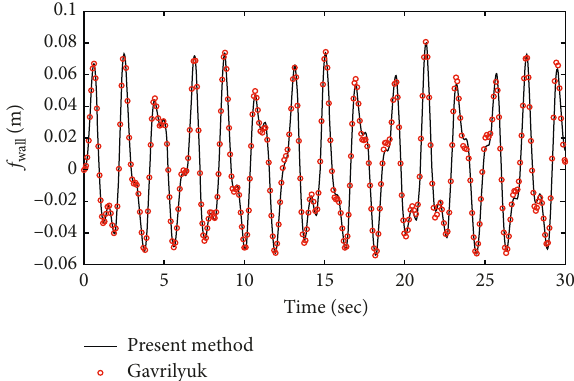
Figure 8: Time history of the surface wave height on the wall at θ � 0 for ω � 6